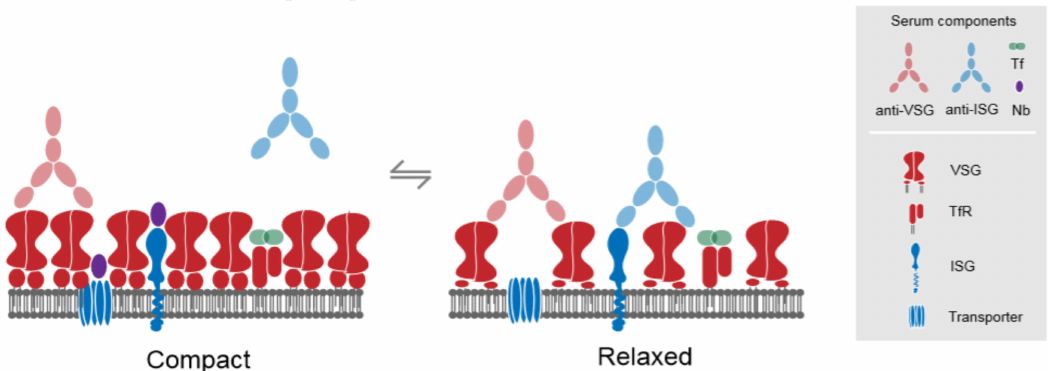
Figure 3. Arrangement of the VSG coat at the cell surface. VSGs form a physical barrier on the plasma membrane to protect the underlying and invariable membrane proteins, thereby preventing the exposure of potentially highly antigenic proteins. During VSG switching and other dynamic conditions, the surface must accommodate a greater number of VSG molecules, which is thought to be achieved by tightly packing VSG under a “compact” conformation. When the VSG switching program is completed and the old VSG is completely removed from the surface, the density of the newly formed VSG coat is reduced, leading to a “relaxed” conformation. It is likely that these conformations are dynamic at the steady-state level, and have important consequences for immune recognition, so that the antibody against invariant determinants (blue) is more likely in the relaxed state. Abbreviations: VSG, Variable Surface Glycoprotein; ISG, Invariant Surface Glycoproteins, Tf, Transferrin; TfR, Transferrin Receptor; Nb,